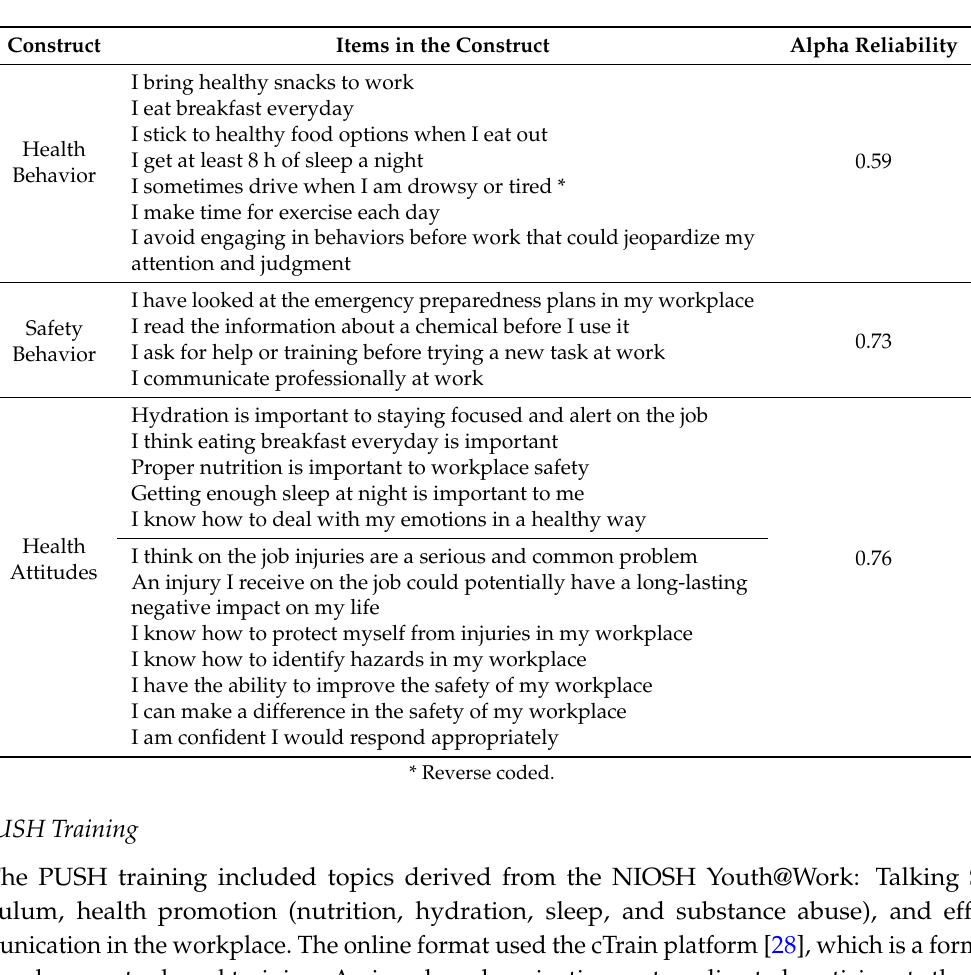
Table 2. Behavior and attitude constructs.